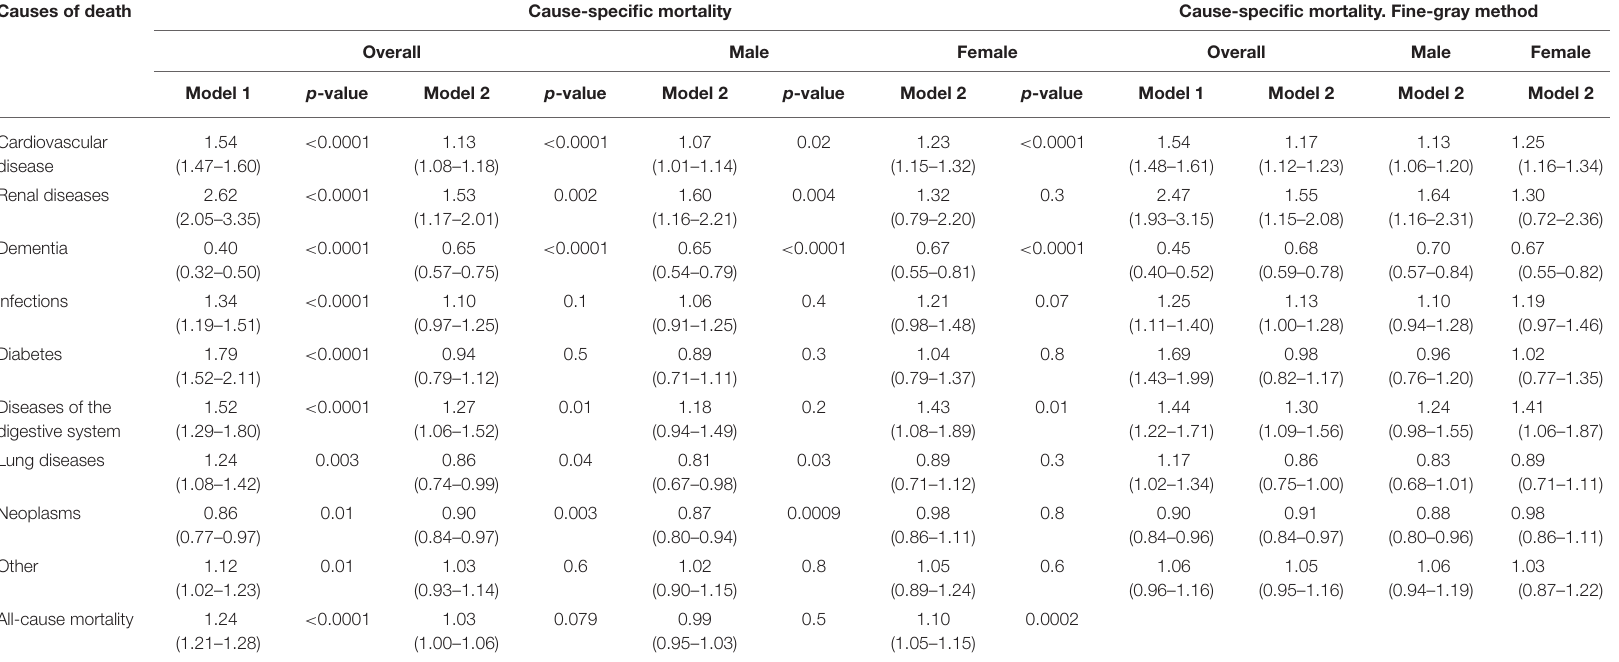
TABLE 4 | Total and cause-specific mortality, overall and stratified by sex, in gout cases compared to controls. Causes of